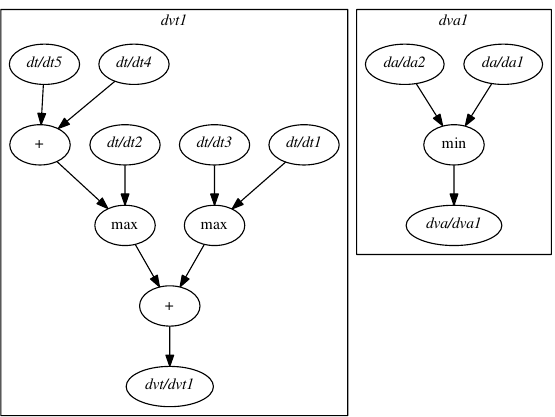
Figure 7. A street segment, evaluation model; DSG Θ complying with the Θ (evaluation)